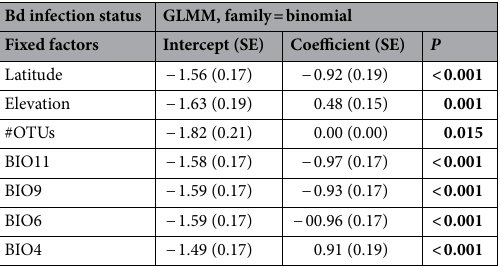
Table 2. Results of separate generalized mixed models (GLMMs) testing the effect of temperature seasonality (Bio4), minimum temperature of the coldest month (Bio6), mean temperature of the driest quarter (Bio9), mean temperature of the coldest quarter (Bio11), latitude, OTU richness (#OTUs), and elevation on Bd infection status in treefrogs in the Brazilian Atlantic Forest. For each fixed factor in the eight models, intercept, coefficients, standard error and the P value are shown. Bold P values indicate a significant effect of the fixed factor. Location:sampling date:host species was used as nested random factor. P values ware corrected for multiple-comparisons with Bonferroni correction. N =